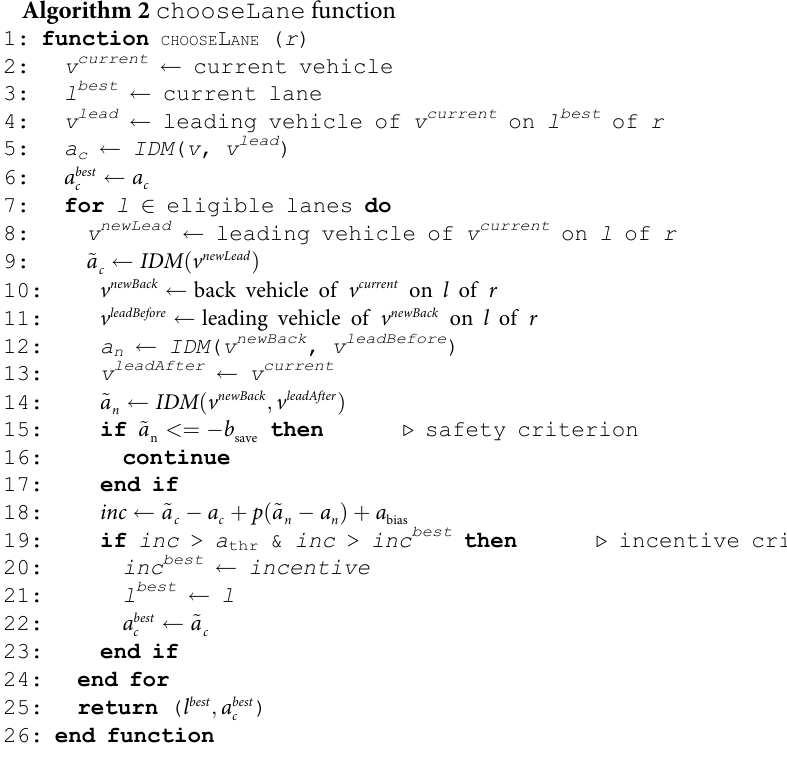
Algorithm 2 chooseLane function